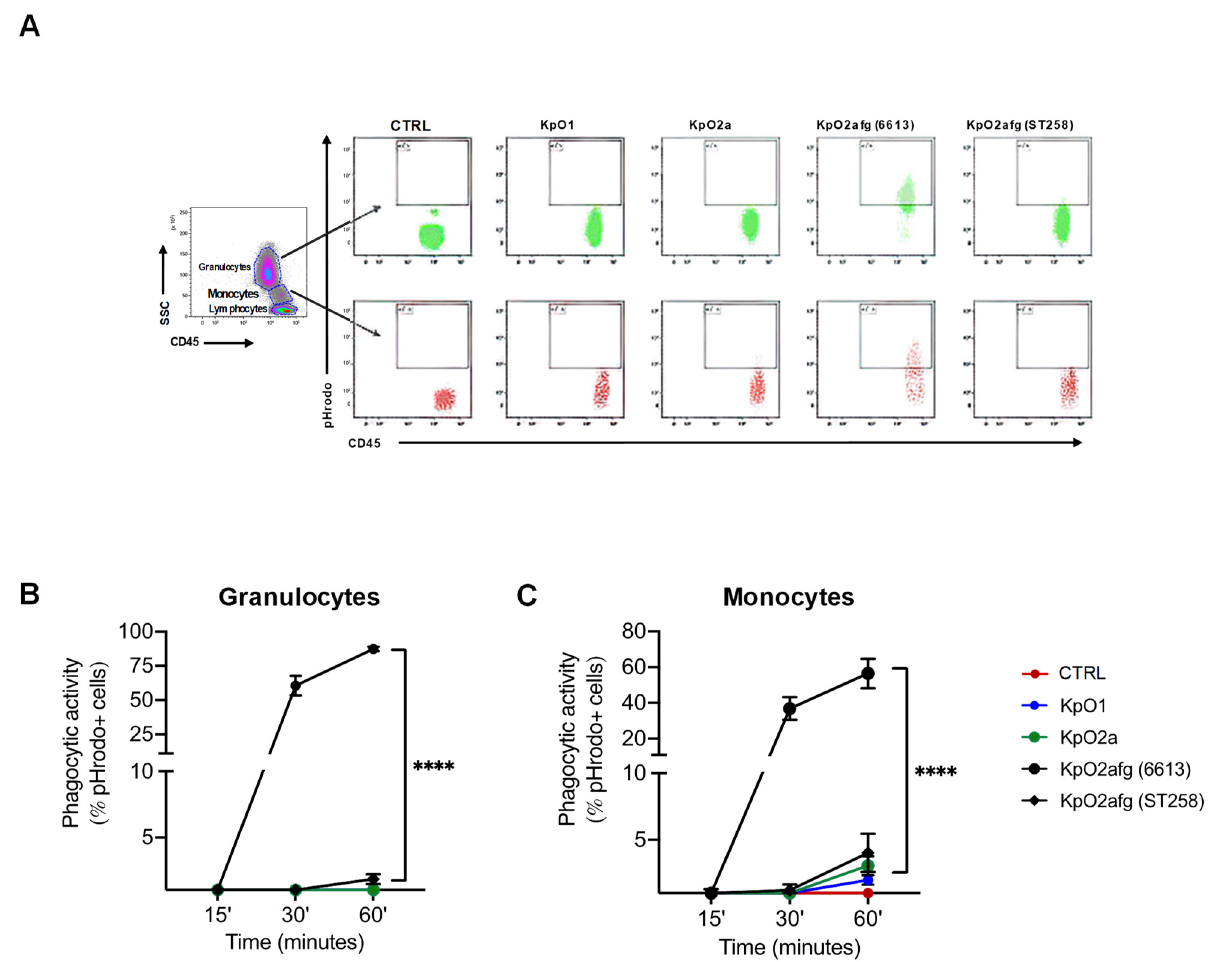
Figure 4. Phagocytosis of K. pneumoniae strains (KpO1, KpO2, KpO2afg (6613) and KpO2afg (ST258)) in peripheral whole blood. ( A ) Flow cytometry plots with gating strategy and phagocytic activity levels of ( B ) granulocytes and ( C ) monocytes are shown. Phagocytosis was measured after 60 min of incubation with stained bacteria using the pHrodo™ Red Phagocytosis Particle labelling kit. CTRL refers to the control used, i.e., phagocytosis blocked by incubation in ice for 60 min, and is representative of what was observed for all controls of the K. pneumoniae strains used in this experiments. Statistical analysis was done using ordinary one-way ANOVA, **** p < 0.0001.